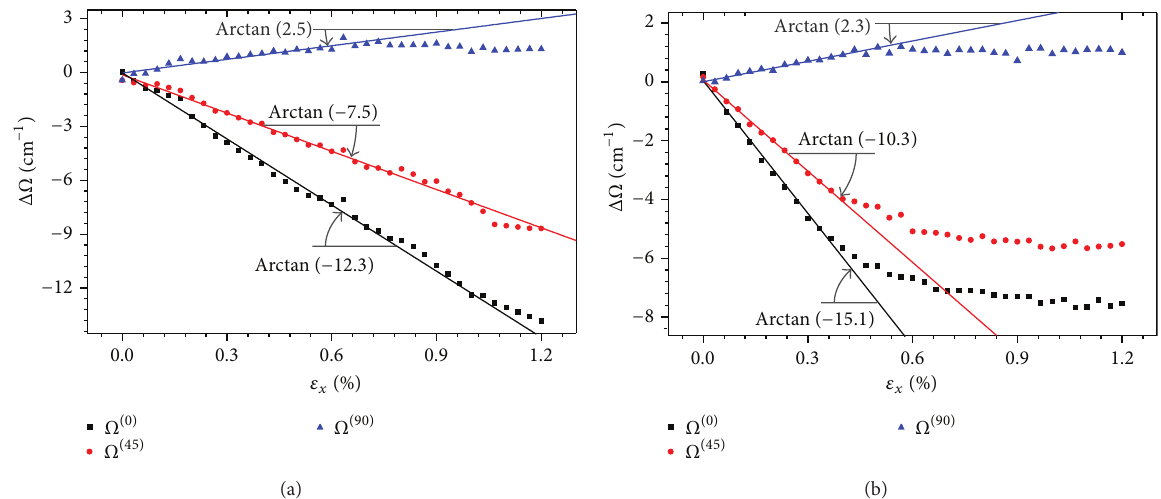
Figure 5: The results of the calibration experiments on (a) Film-I and (b) Film-II.